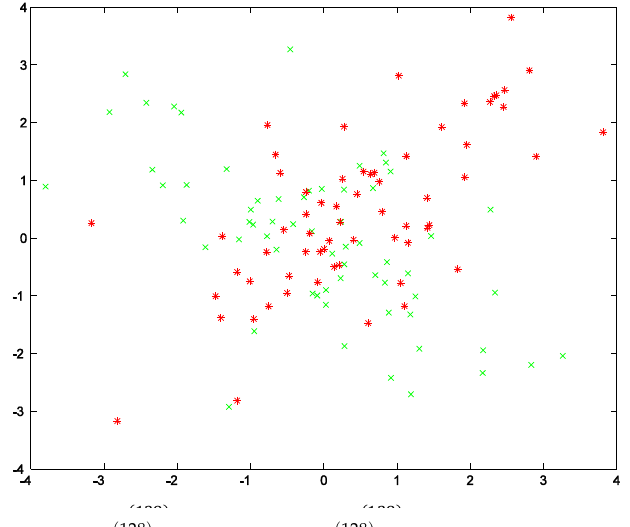
Figure 5. 𝑤 𝑡(128) as a function of 𝑤 𝑡−1(128) (crosses: 𝑡 ≤ 64 , stars: t > 64).